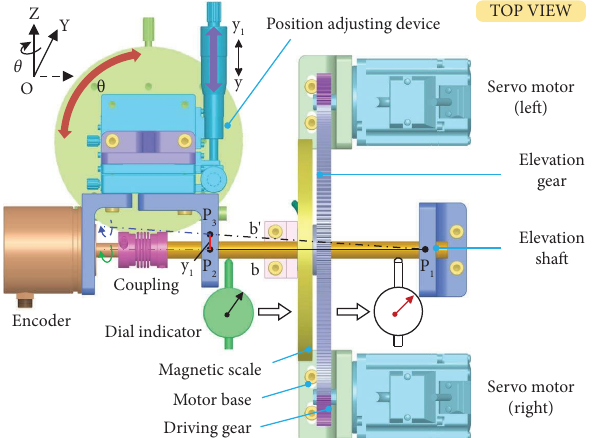
Figure 10: Te elevation shaft is adjusted in the direction of the Y axis. Table 1: Te relationship between y